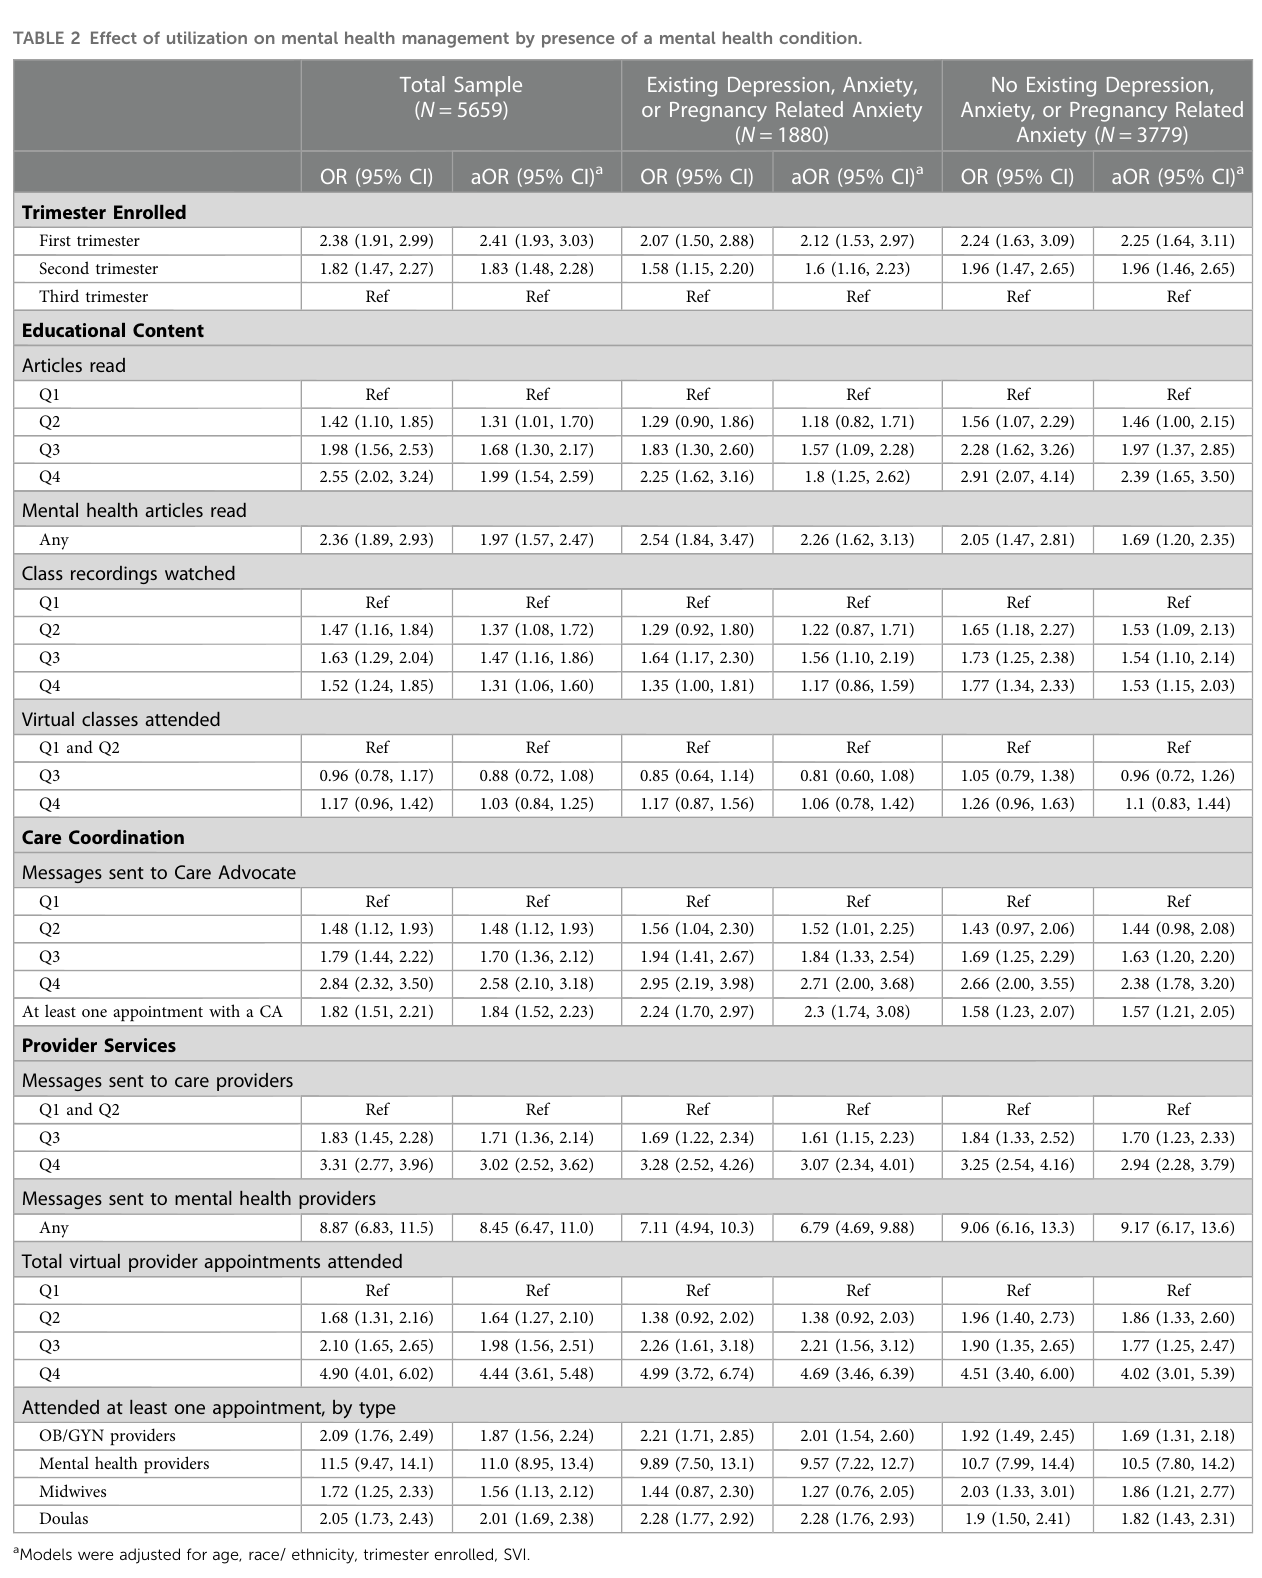
TABLE 2 Effect of utilization on mental health management by presence of a mental health condition.